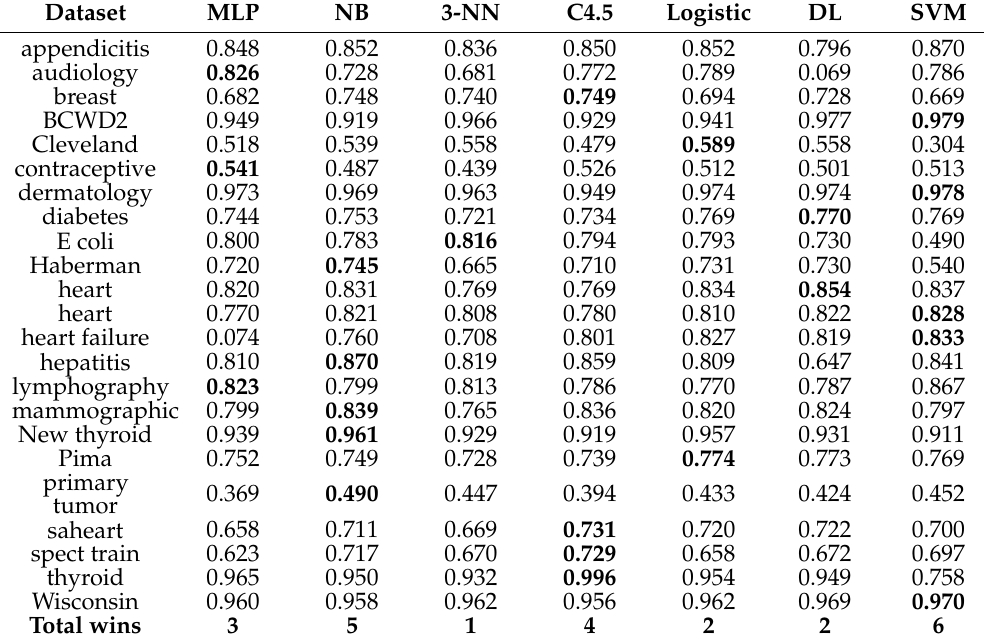
Table 6. Performance of the classifiers using Specificity as a